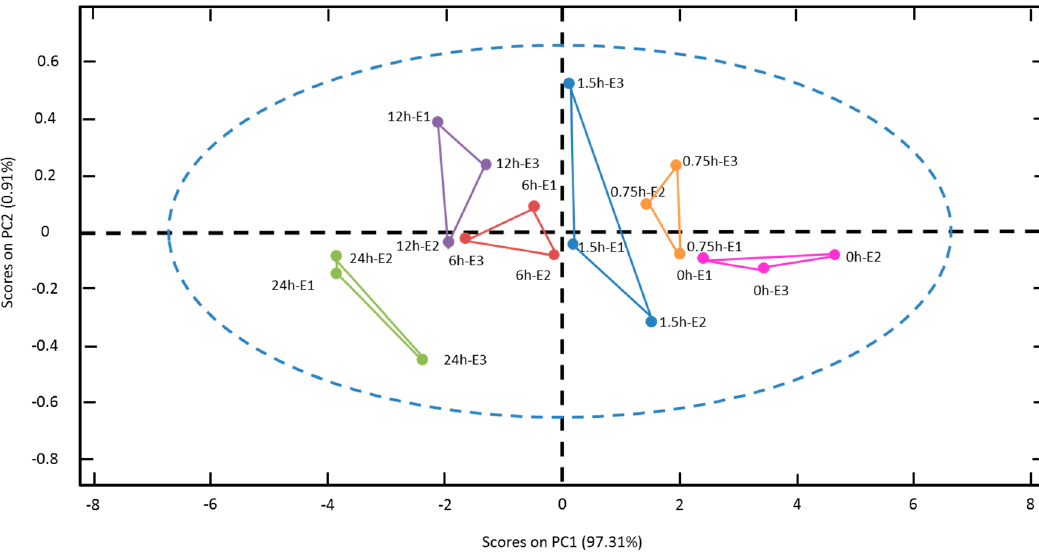
Figure 4. Principal component analyses (PCA) biplot for EIS phase data (6.6 × 10 5 Hz–7.0 × 10 5 Hz) during pineapple waste saccharification (0 to 24 h). R1-3: average of each replicate. The blue ellipsis indicates 95% confidence level.